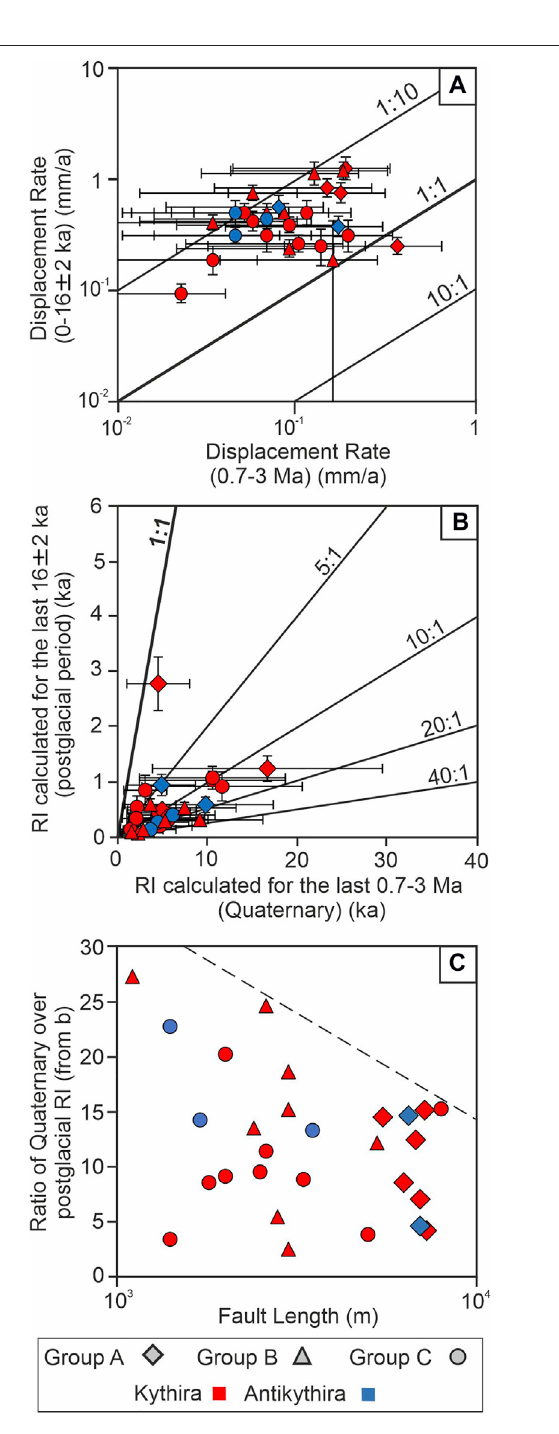
FIGURE 7 | (A) Log-log plot illustrating the relationship between the short-term (16 ± 2 ka) and long-term (0.7 – 3 Ma or 1.85 ± 1.15 Ma) displacement rates on individual faults on Kythira (red) and Antikythira (blue). (B) Plotcomparingtherecurrenceintervalscalculatedonindividualfaults over the two distinct time-intervals examined here. (C) Semi-logarithmic plot showing, for each onshore fault, the ratio of “ long-term ” over “ short-term ” recurrence interval calculated in (b), as a function offaultlength. Black dashed black line highlights likely trend, suggesting that the variability in earthquake recurrence may decrease with increasing